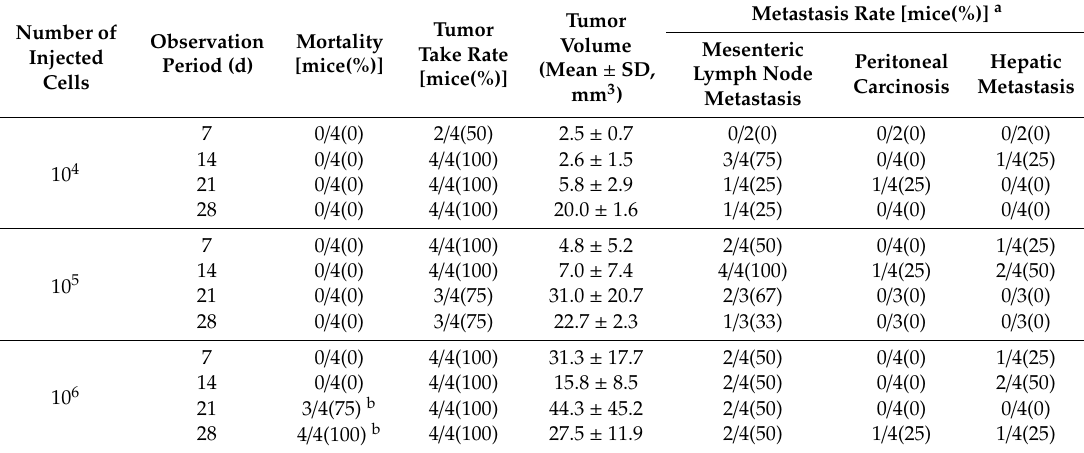
Table 1. Outcomes after endoscopy-guided injection of CT26 cells into BALB / C mice: mortality within the observation period, tumor take rate, tumor volume, and the rates of distant metastasis in experimental groups with varying number of cells injected or observation periods.